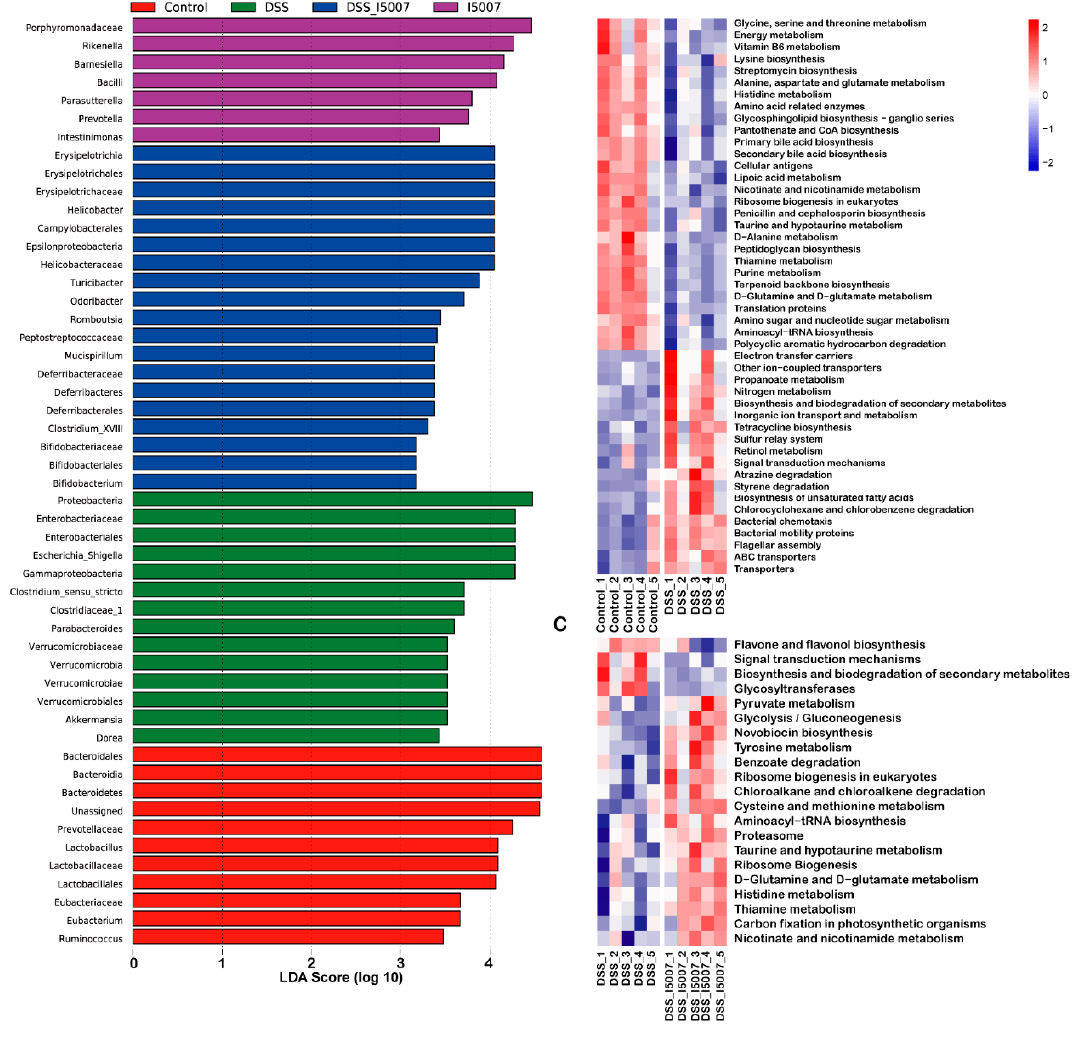
Figure 5. Effects of L. reuteri I5007 pretreatment on colonic ‐ specific bacterial taxa and microbiota functional composition. ( A ) Histogram of the linear discriminant analysis (LDA) results for the differentially expressed features; ( B ) heatmap of significantly enriched Kyoto Encyclopedia of Genes and Genome (KEGG) pathways between the control and DSS groups; ( C ) heatmap of significantly enriched KEGG pathways between the DSS and DSS_I5007 groups. The significance of KEGG pathways compared across groups using Statistical Analysis of Metagenomic Profiles.